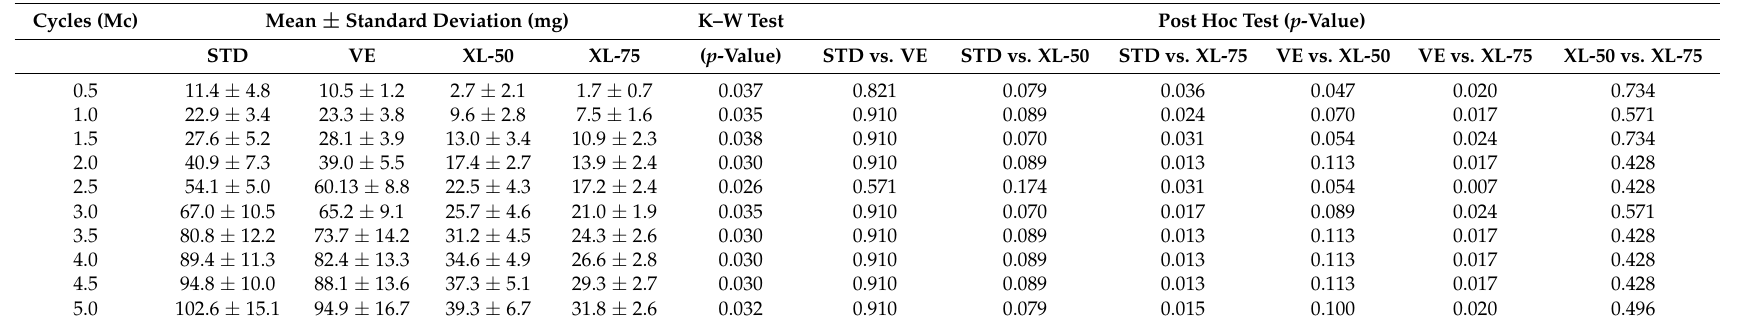
Table 1. Cumulative mass loss (mean ± standard deviation) for the four sets of polyethylene (PE) acetabular cups tested. Values and statistical analysis performed using a Kruskall–Wallis nonparametric